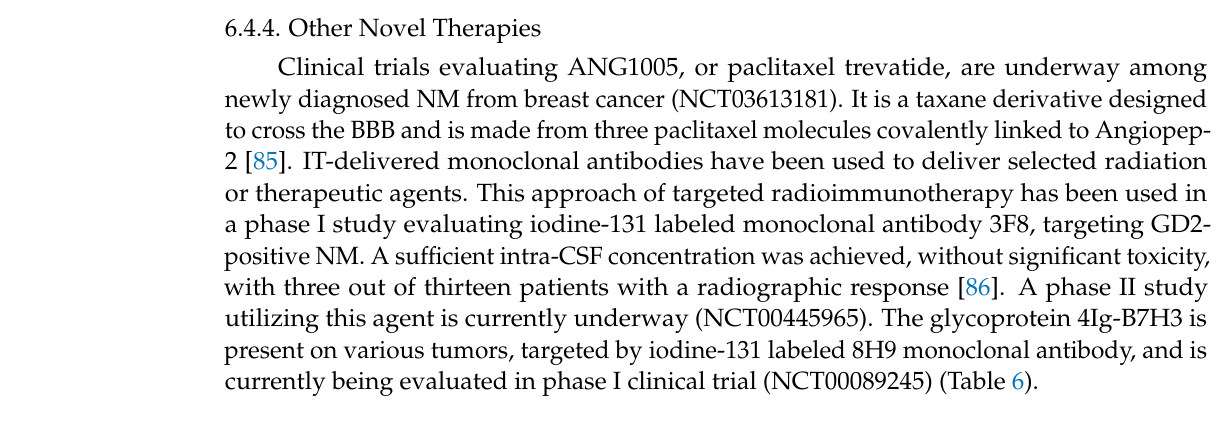
Table 6. Overview of Clinical trials evaluating intrathecal therapies in neoplastic meningitis. Original table, updated till October 2022. Abbreviations: OS: Overall survival, PFS: Progression-free survival, DLT, ORR: Objective Response Rate, RR: Response Rate, N: Number of patients, NSCLC: Non-Small Cell Lung Cancer, SCLC: Small Cell Lung